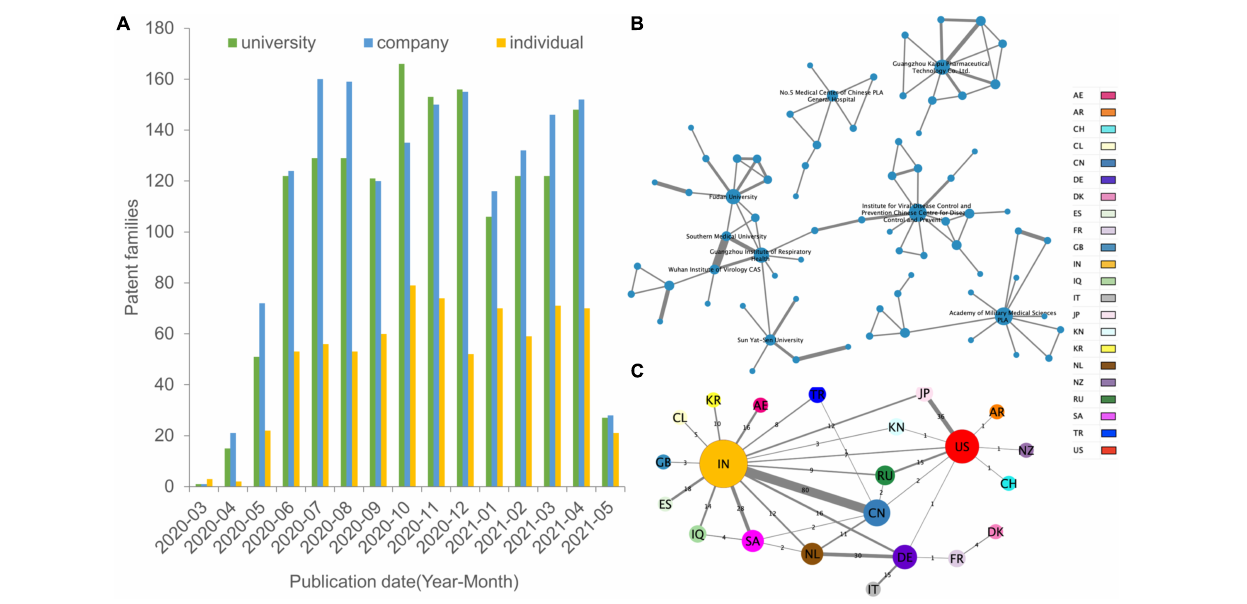
FIGURE 2 | Spatial and institutional dimensions of research collaboration. (A) The bar chart shows the patent numbers for each assignee type of institution. (B) Top collaboration partners. The nodes (organizational patent assignee colored with country) and edges (collaboration) in the network visualization map represent the co-assignee relations. The institutional collaboration network does not include the individual assignee and labels names of top active institutions by Cytoscape. (C) Networks of country relationship modes. Nodes (individual and organizational patent assignees) denote locations, and edges denote the count of domestic, bilateral, and multilateral country collaborations. Node size is scaled to the numerical value of the network degree (co-patent number), while the thickness of the edges is determined by the numerical value of the network weighted degree (frequency of cooperation). Countries are represented in different colors. The regional cooperation network is displayed in the “yFiles Organic layout” based on the force-directed layout paradigm by